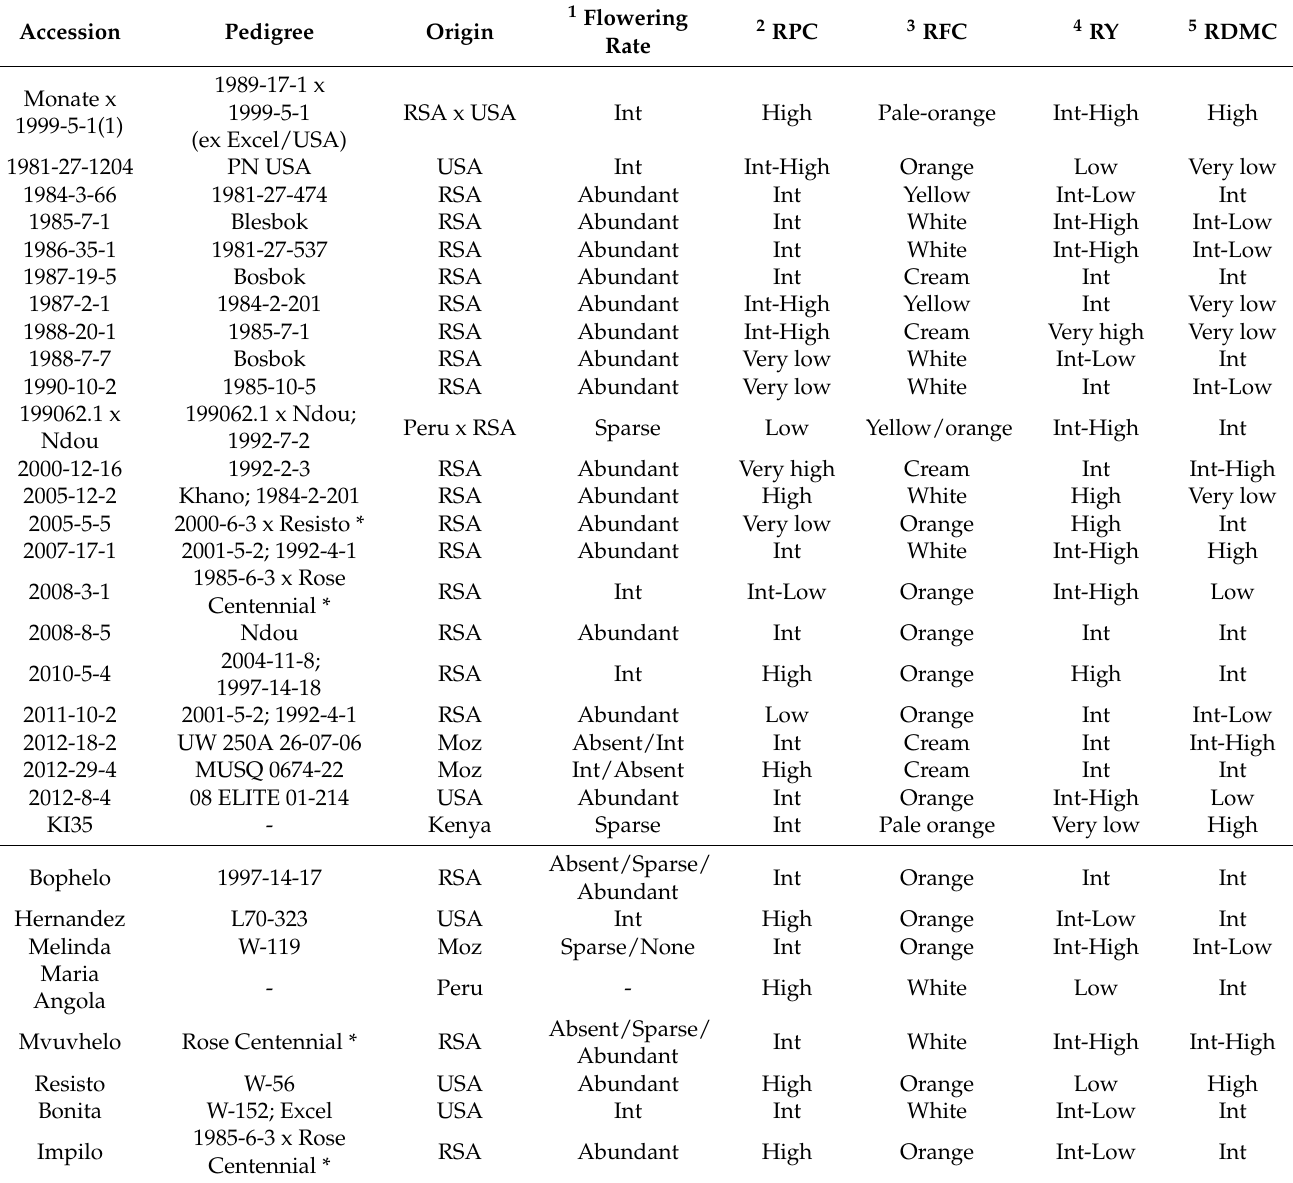
Table 1. Sweetpotato genotypes used for SSR genetic diversity analysis and a summary of their pedigree, origin, and agronomic